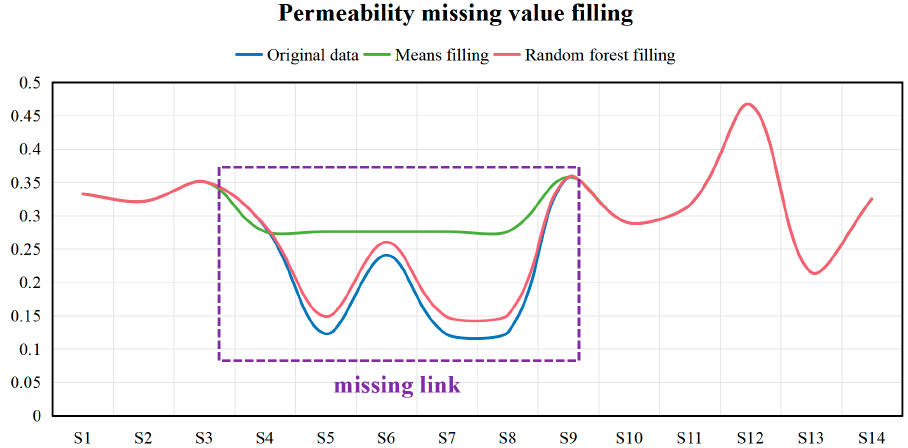
Figure 6. Different methods to filling missing values.